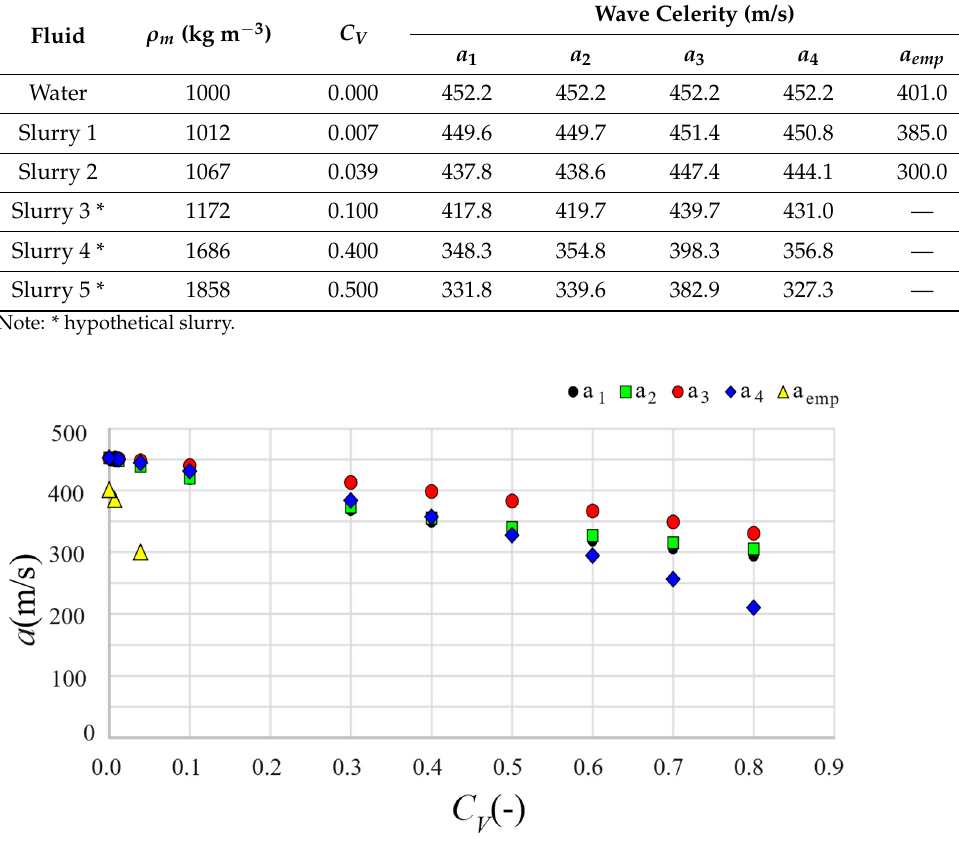
Figure 4. Pressure wave celerity for different mixture concentrations.